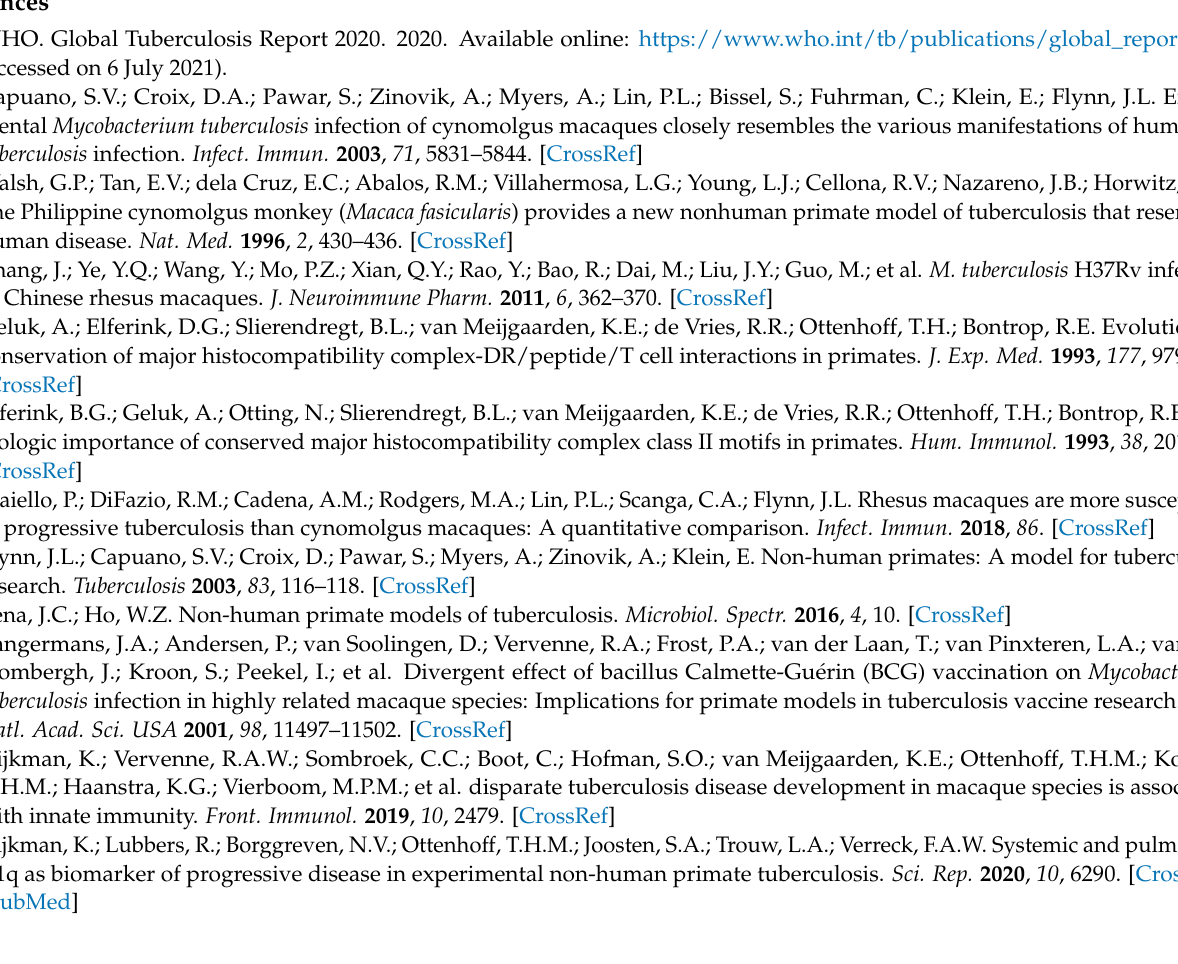
marmosets with humans; Figure S1: Assessment by UCP-LFA of 11 serum proteins as putative markers of experimental TB infection in rhesus macaques; Figure S2: TB disease manifestation in rhesus macaques; Figure S3: Heatmap showing SAA1, IP-10 and IL-6 levels of each rhesus macaque pre- and post-MTB infection; Figure S4: Correlation between three biomarkers; Figure S5: SAA1, IP-10 and IL-6 levels in two rhesus genotypes that differ in disease susceptibility; Figure S6: Heatmap for 3 biomarker signatures for TB in two genotypically different rhesus macaques; Figure S7: TB disease manifestation in rhesus macaques; Figure S8: BCG vaccination decreases SAA1, IP-10 and IL-6 levels in serum after MTB infection; Figure S9: Heatmap for 3 biomarker signatures for TB in rhesus macaques with different disease